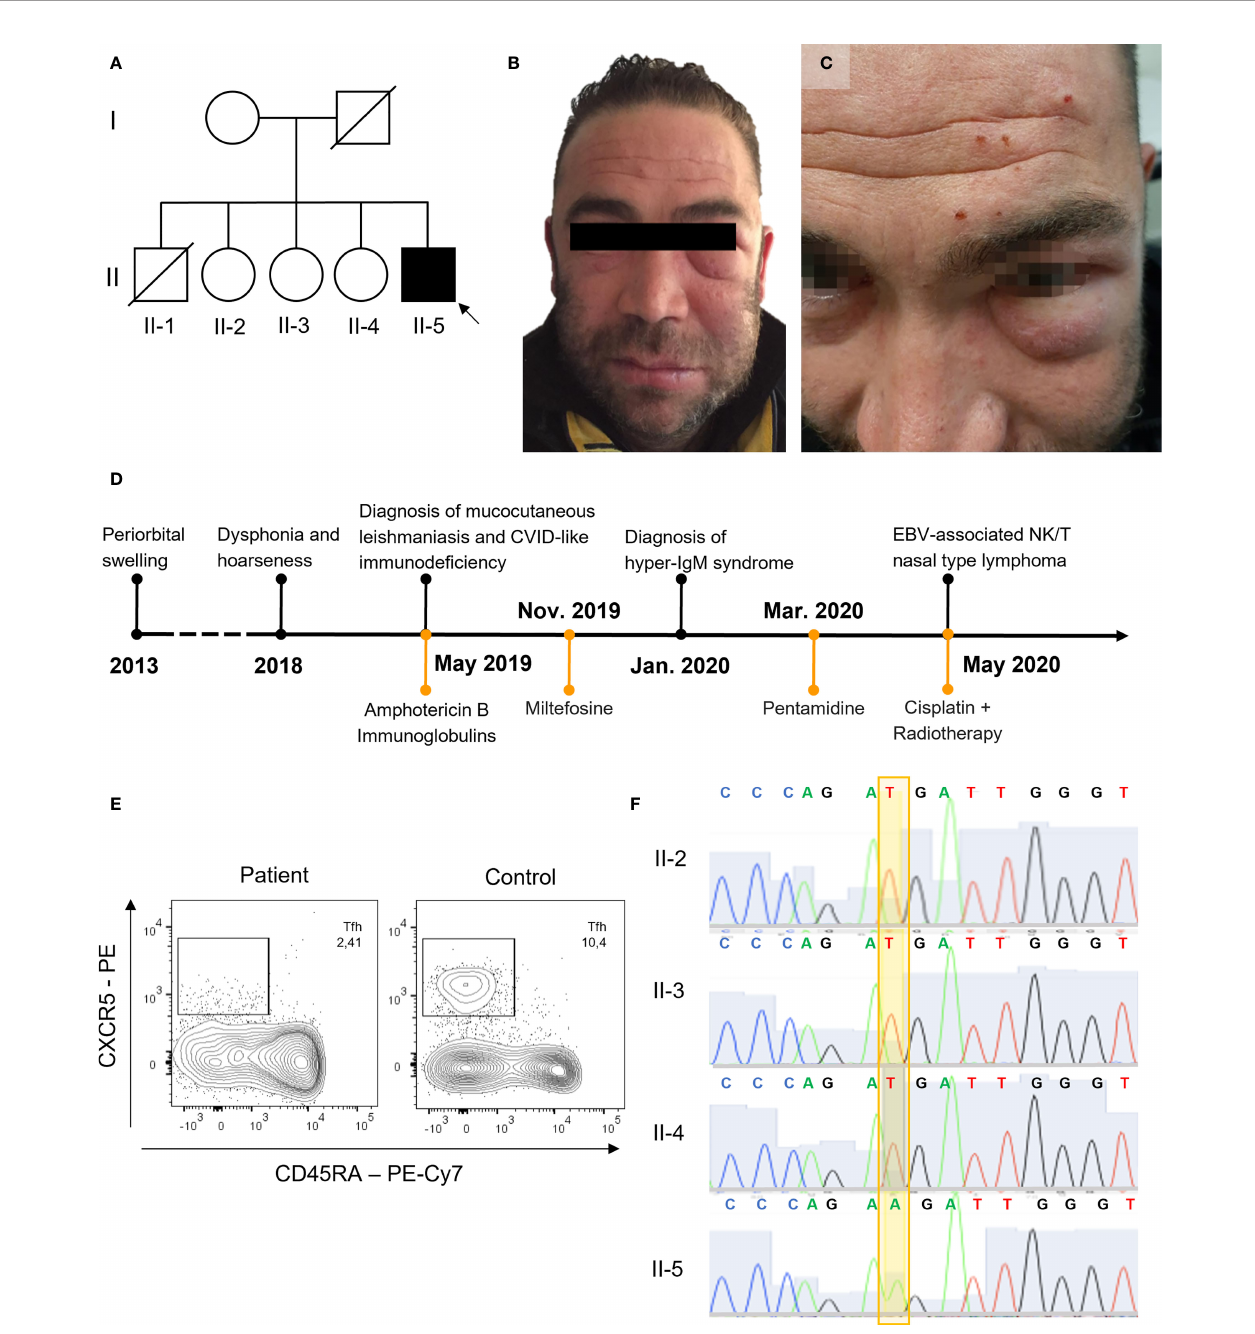
FIGURE 1 | Clinical presentation and genetic analysis. (A) Family pedigree, black background used for CD40LG variant. (B, C) Periorbital swelling. (D) Timeline of clinical events and therapy. (E) Tfh in the index patient and a representative control (gated on CD3+CD4+ lymphocytes from whole-blood). (F) Sanger sequencing of CD40LG (NM_000074) c.107T>A